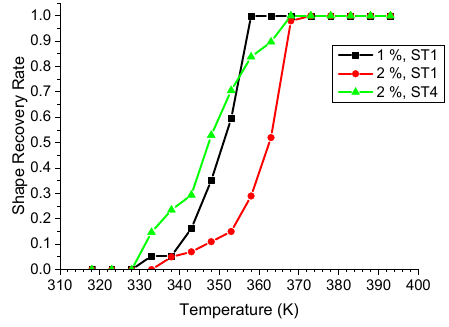
Figure 9. Temperature dependence of the shape recovery rate for the ST1 and ST4 samples.